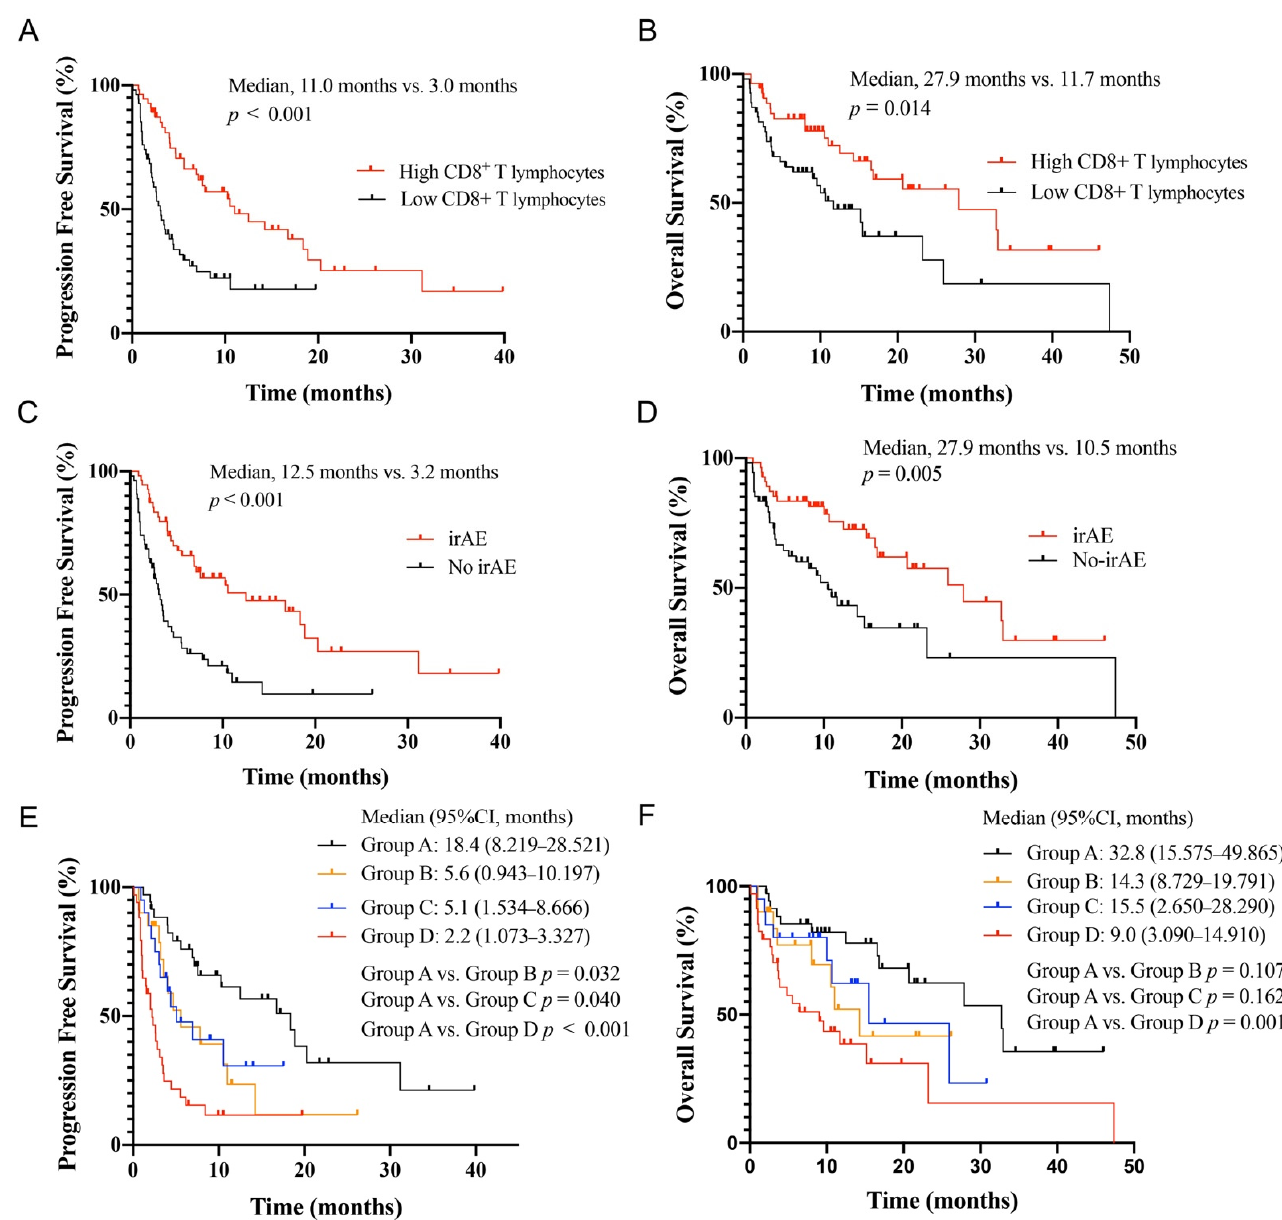
Figure 2. Association between baseline peripheral blood CD8 + T lymphocytes, immune-related ad- verse events (irAEs), and survival in non-small cell lung cancer patients treated with ICIs. PFS ( A ) and OS ( B ) curves of patients according to baseline peripheral blood CD8 + T lymphocytes. PFS ( C ) and OS ( D ) curves of patients stratified according to the onset of irAEs. PFS ( E ) and OS ( F ) curves of pa- tients stratified according to baseline peripheral blood CD8 + T lymphocytes and irAEs. Group A, high CD8 + T lymphocytes and irAEs; Group B, low CD8 + T lymphocytes and irAEs; Group C, high CD8 + T lymphocytes and no irAEs; and Group D, low CD8 + T lymphocytes and no irAEs. Abbreviation: ICIs, immune checkpoint inhibitors; PFS, progression-free survival; OS, overall